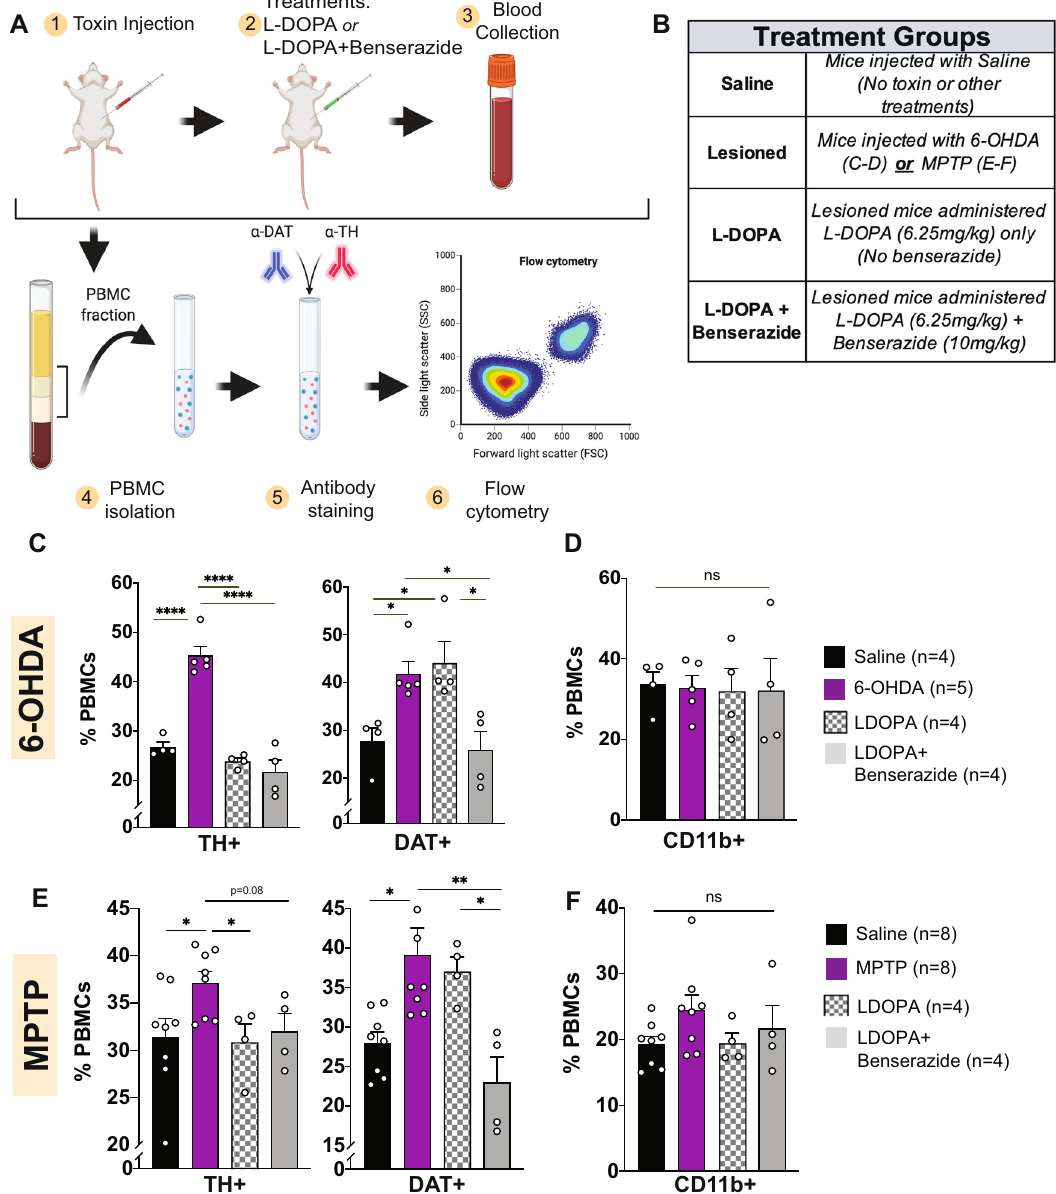
Fig. 3 Depletion of dopamine neurons with 6-OHDA or MPTP in mice increases numbers of DAT + and TH + PBMCs and treatment with L-DOPA + Benserazide restores baseline levels. Treatment with L-DOPA alone restored DAT + but not TH + PBMCs. A Schematic of experimental design using toxin-induced lesions. B Animals were grouped by treatment conditions as shown. C , D Bilateral infusion of 6-OHDA (5 mg/mL) into the median forebrain bundle, or acute depletion by four i.p. MPTP injections ( E , F ) reveal that PD-like lesions in mice reproduce the phenomena observed in Parkinson ’ s patients and healthy controls. C , E Both TH + and DAT + cells are increased following dopamine neuron depletion with 6-OHDA ( C ) or MPTP ( E ). TH + and DAT + cells are restored to, or trend towards, healthy levels following treatment with L-DOPA + AADC inhibitor Benserazide. In both PD models, TH-expressing cells are reduced to near-healthy levels following LDOPA treatment alone, while DAT-expressing cells are reduced to healthy-levels only with L-DOPA + Benserazide, suggesting separate regulatory steps for DAT and TH expression in peripheral immune cells. D , F Total myeloid cells, de fi ned by CD11b expression, are not changed amongst treatment groups in either model. All data shown are